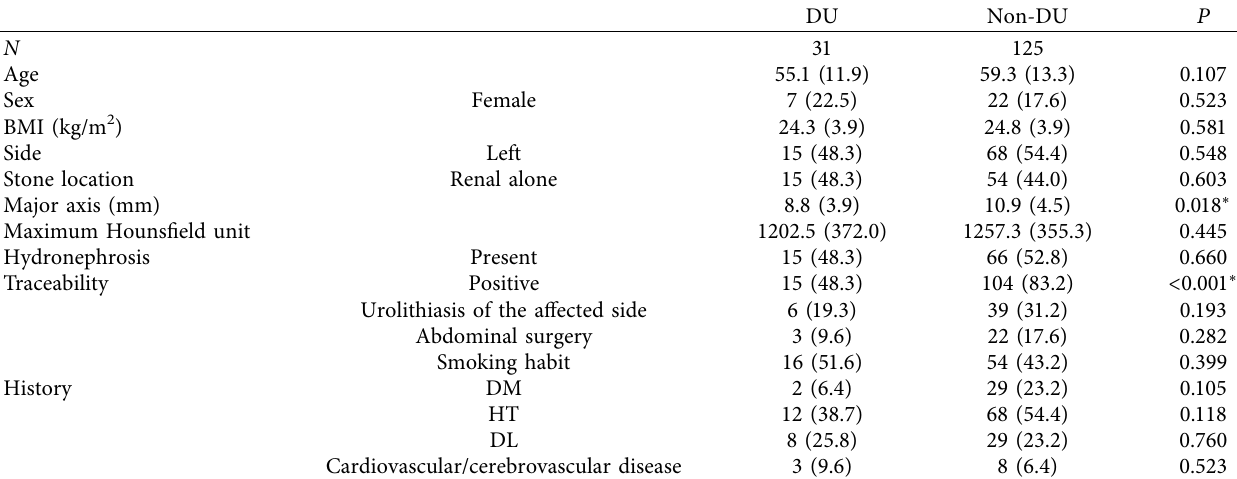
Table 1: Patients